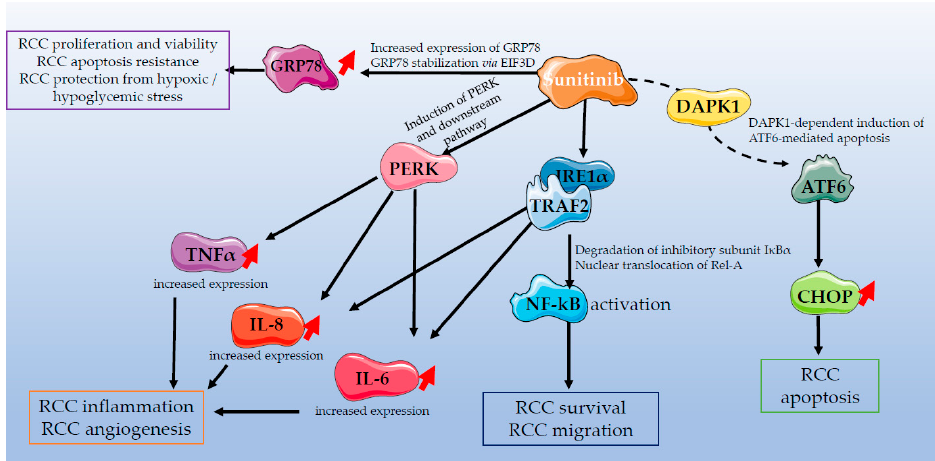
Figure 6. Interplay between Sunitinib treatment and ER stress signaling pathways in renal cell carcinoma. Graphical representation was designed using images from the Servier medical art database.